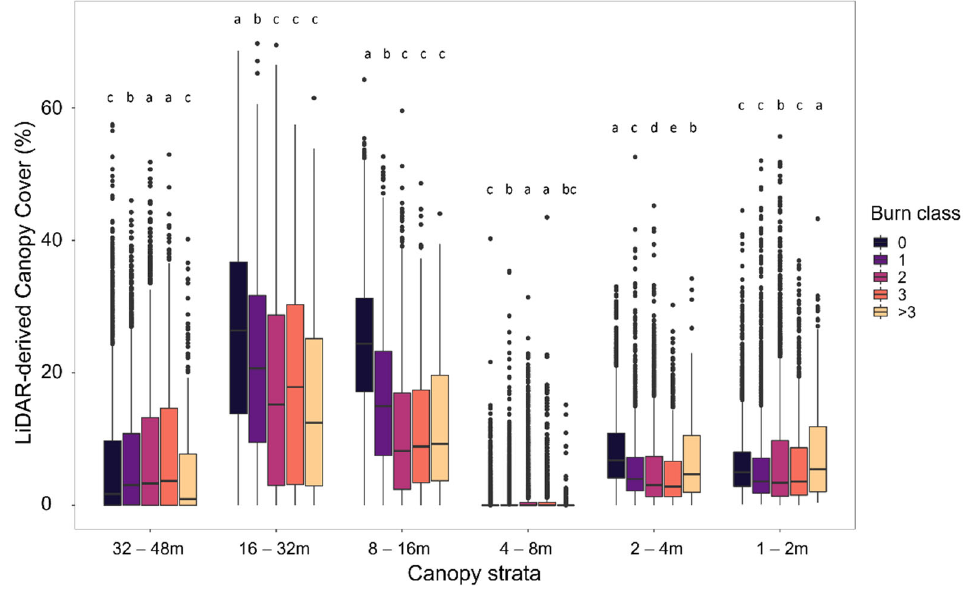
Figure 5. Normalized difference vegetation index (NDVI) values across differing burn classes. Higher NDVI values indicate more vegetation ‘greenness’. Letters are ordered alphabetically according to the magnitude of the mean value in each group (‘a’ corresponds to the group with the largest mean value) and different letters represent statistically significant differences in means according to one ‐ way analysis of variance.